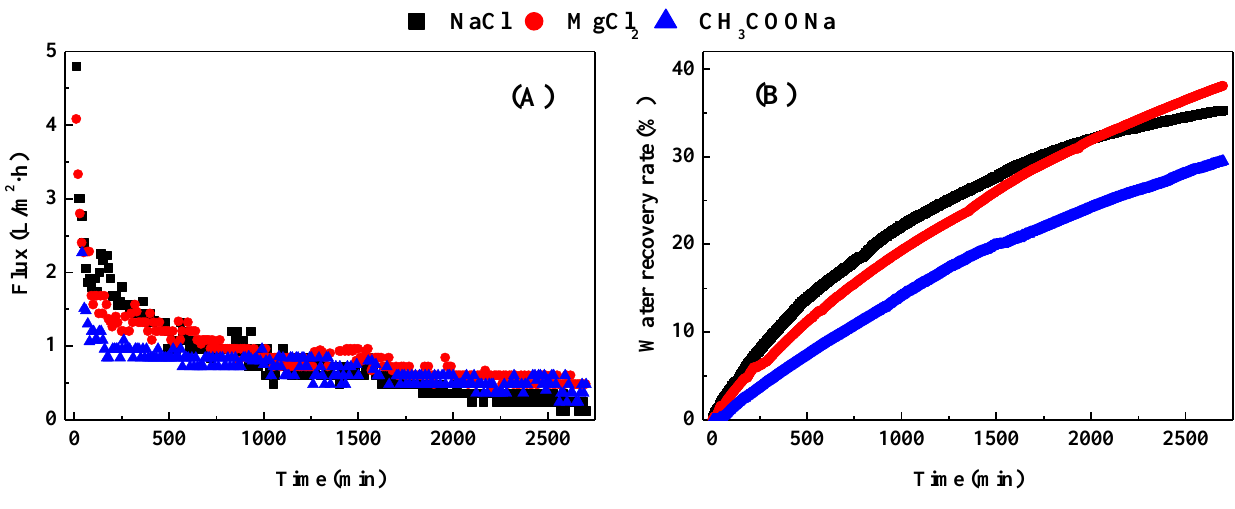
Figure 2. Water fluxes of each treatment ( A ) and their water recovery rate ( B ) during concentration of biogas slurry. NaCl represents the treatment with 0.5 mol/L NaCl as the draw solution. MgCl 2 represents the treatment with 0.5 mol/L MgCl 2 as the draw solution. CH 3 COONa represents the treatment with 0.5 mol/L CH 3 COONa as the draw solution. The FO process was operated in the osmotic dilution mode with 500 mL biogas slurry and 500 mL different draw solution as the initial feed and draw solutions at a cross-flow velocity of 8.3 cm/s, respectively.